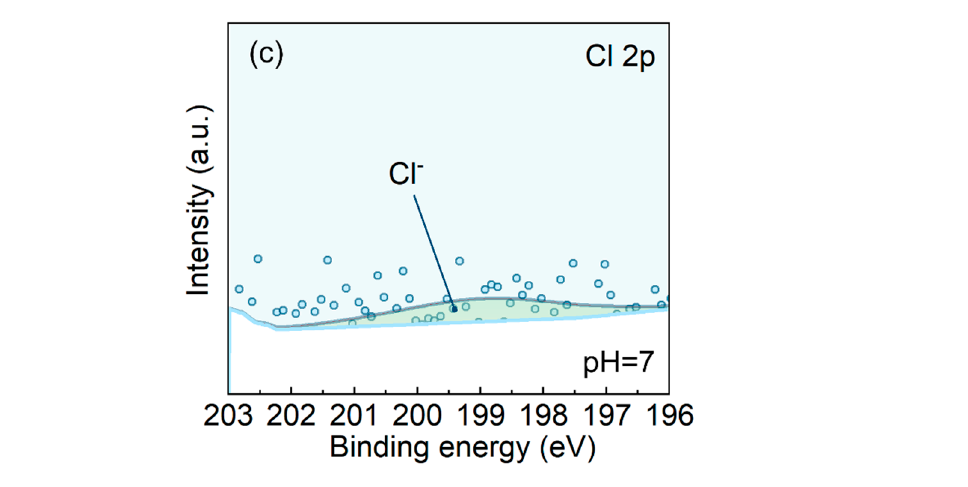
Figure 9. Cl 2p spectra for passive films formed on the surfaces of LPBFed Ti–6Al–4V under 1.0 V SCE in Hank’s solution, with pHs of ( a ) 3, ( b ) 5, and ( c ) 7.